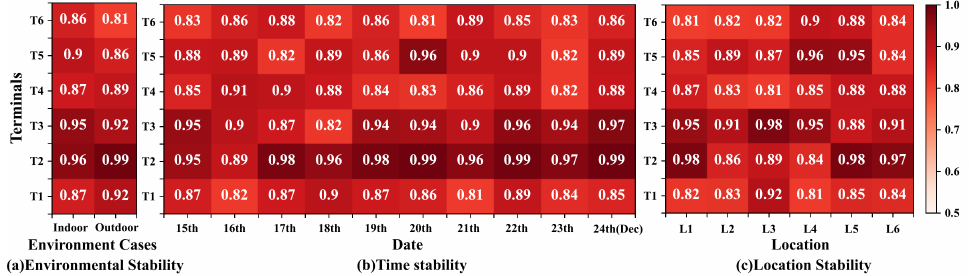
Figure 10. The evaluation results of environmental stability, time stability, and location stability of device fingerprints extracted by